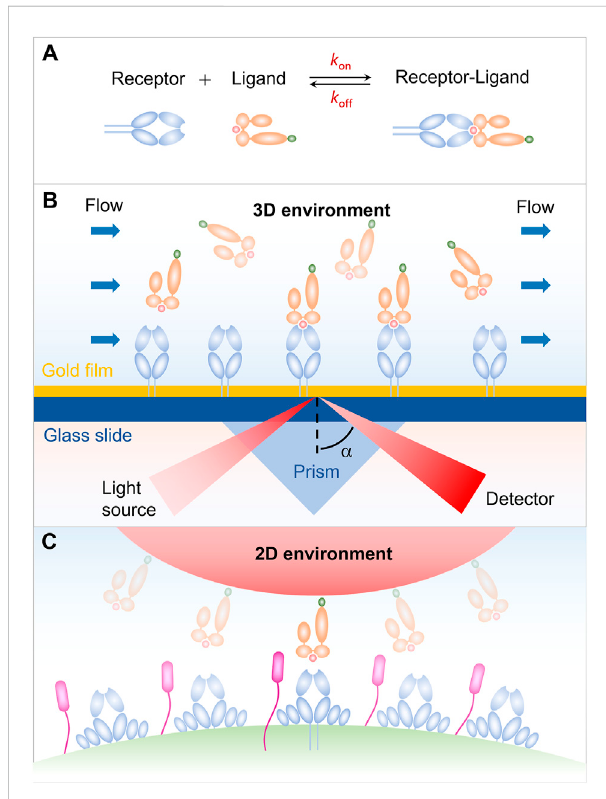
FIGURE 1 Receptor-ligand interaction in three-dimensional (3D) and two- dimensional (2D) environments. (A) Schematic of an af fi nity reaction. (B) Interaction in 3D environment. (C) Interaction in 2D